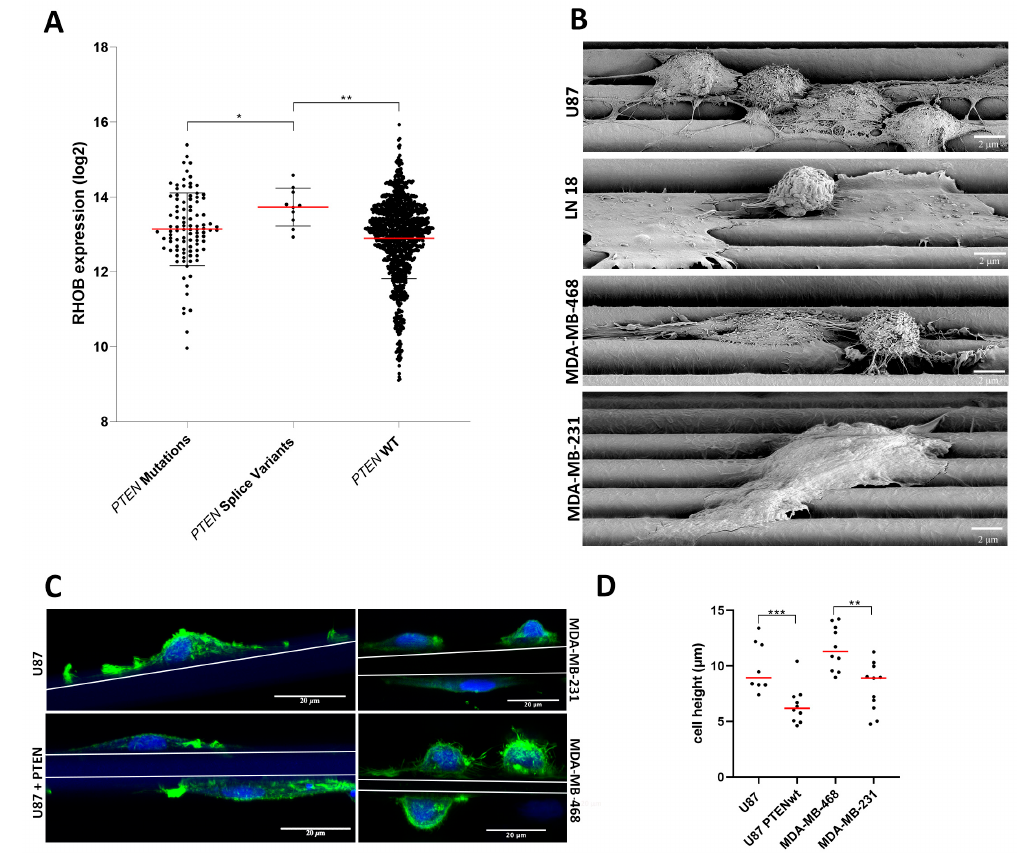
Figure 7. RHOB signaling in primary GBM and breast tumors and RHOB regulation of cell morphology. ( A ) Correlation of PTEN wt or PTEN splice or other mutations with RHOB expression from primary GBM and breast cancers (TCGA); * p = 0.031; ** p = 0.003; PTEN mutations: n = 98 tumors; including GBM ( n = 46 tumors) and breast cancer ( n = 52 tumors). PTEN splice variants: n = 10 tumors; including GBM ( n = 4) and breast cancer ( n = 6). PTEN wt: n = 1102 tumors including GBM ( n = 97) and breast cancer ( n = 1005 tumors). ( B ) Representative scanning electron microscopy images on laminin ‐ coated aligned microfibers with U87 PTEN loss of function, LN18 PTEN wt, MDA ‐ MB ‐ 468 PTEN loss of function and MDA ‐ MB ‐ 231 PTEN wt cells at 24 h after seeding (scale bar = 2 μ m). ( C ) Confocal z ‐ stack images of F ‐ actin Alexa 488 staining of U87 PTEN loss of function control cells (top left) vs. U87 cells after PTEN wt transfection and rescue (bottom left); and MDA ‐ MB ‐ 231 PTEN wt (top) vs. MDA ‐ MB ‐ 468 PTEN loss of function cells (bottom) on laminin ‐ coated aligned microfibers at 24 h after seeding (green: F ‐ actin; blue: DRAQ5 indicates nuclei) (scale bar = 20 μ m). ( D ) Quantification of cell height from confocal images ( μ m) (Y ‐ axis) of U87 PTEN loss of function (control) vs. U87 after PTEN wt transfection and rescue and MDA ‐ MB ‐ 468 PTEN loss of function vs. MDA ‐ MB ‐ 231 PTEN wt cells. *** p = 0.0010; ** p = 0.0016.